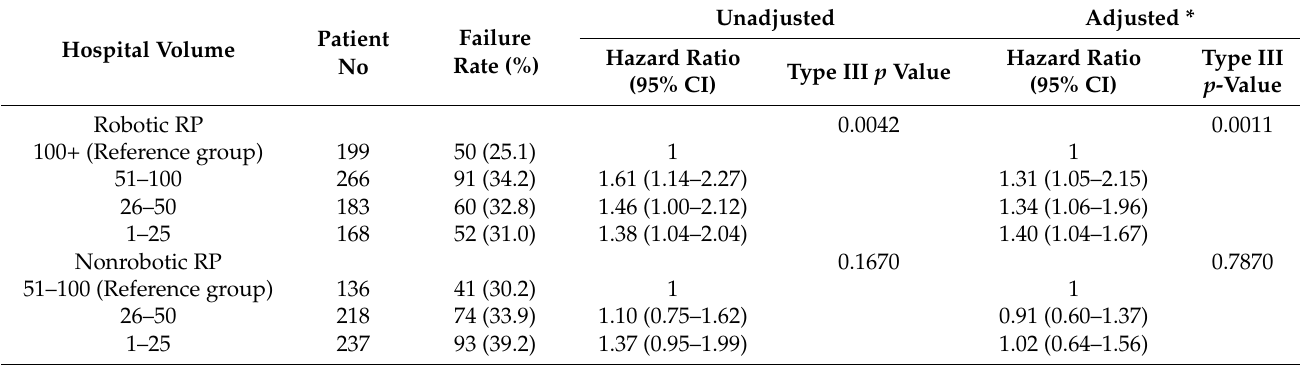
Table 4. Cox regression comparing biochemical failure rates stratified by hospital volume between nonrobotic and robotic radical prostatectomy.